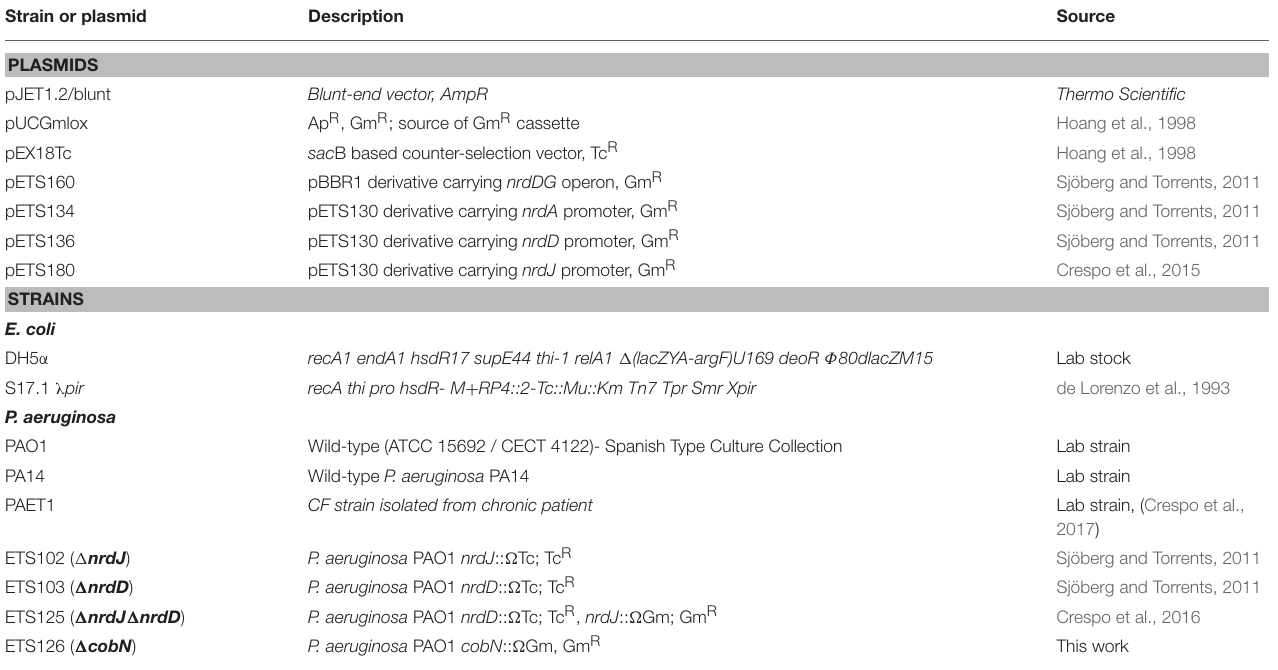
TABLE 1 | Strains and plasmids used in this study.